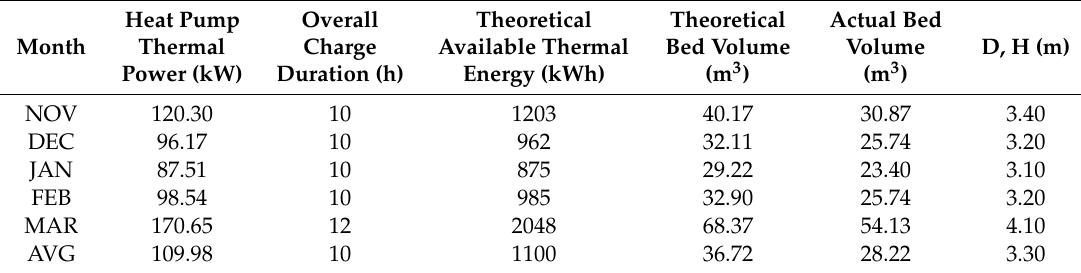
Table 3. Sizing of the TES